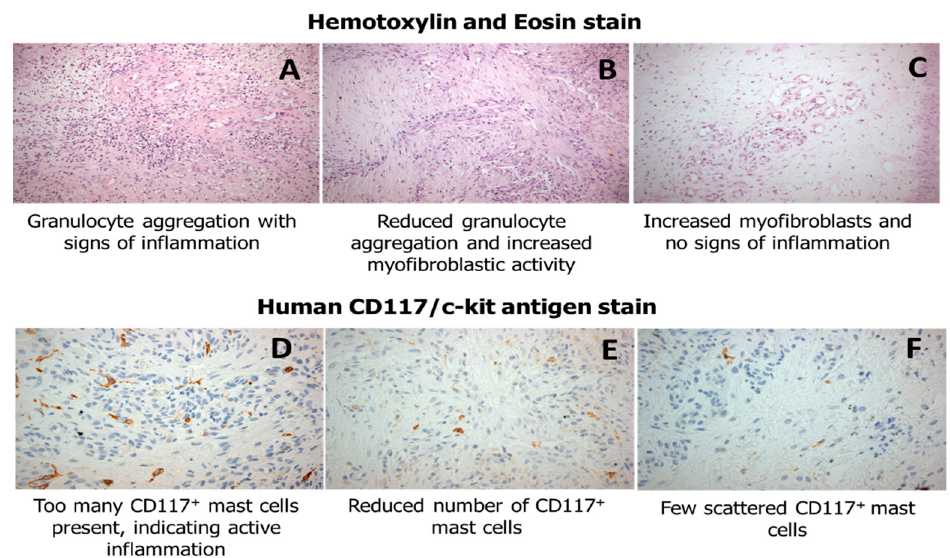
Figure 3. ( A – C ) Hemotoxylin and Eosin immunohistochemistry of tissue biopsies from